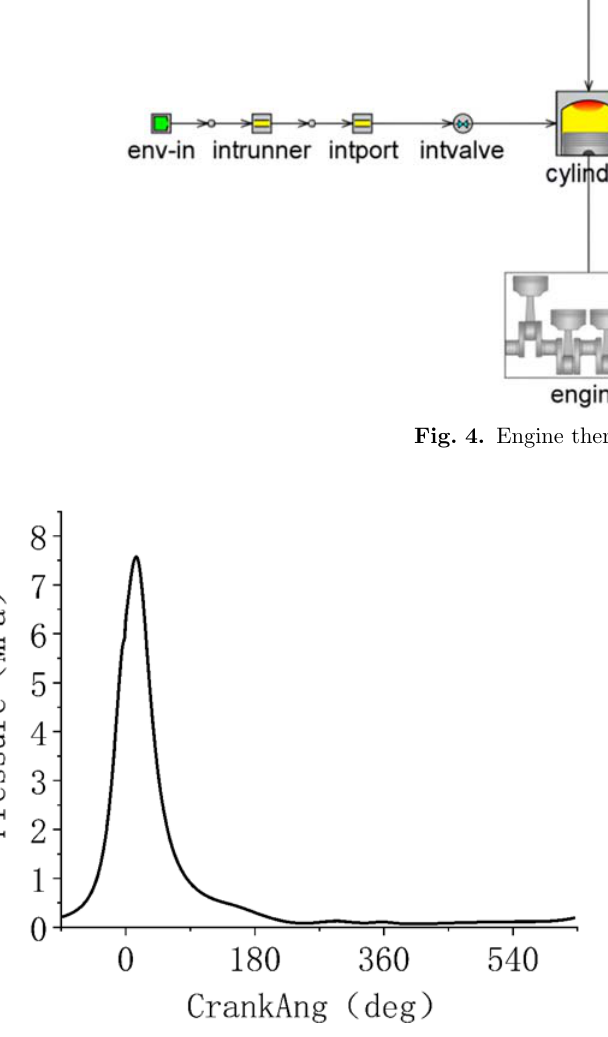
Fig. 5. Combustion chamber pressure variation curve with crankshaft rotation angle.